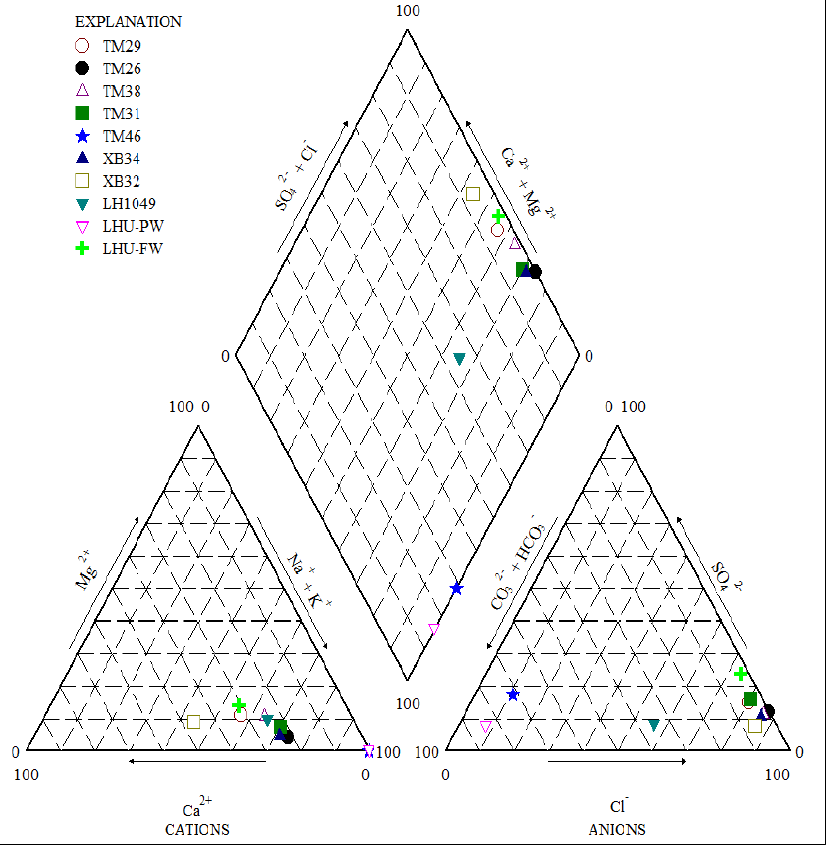
Figure 6. The water samples results plotted on the piper diagram.